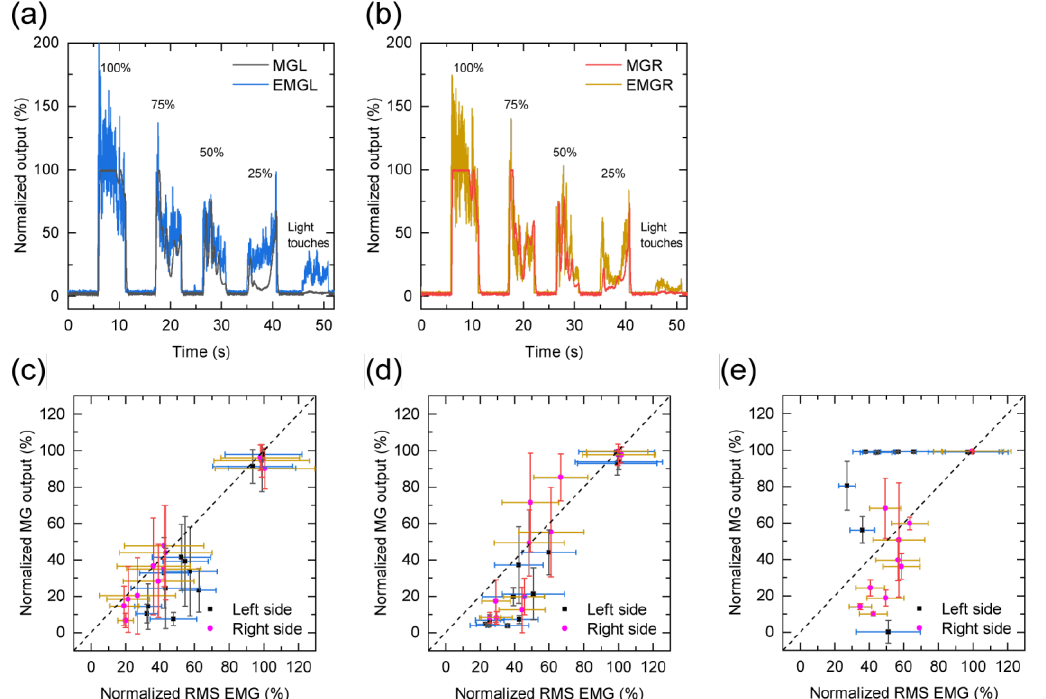
Figure 3. MG sensor outputs and the electromyograms (EMGs) during the teeth-clenching task at four different levels from 100% to 25% in steps of 25% and during light teeth touches. ( a ) Left-side sensors (MGL and EMGL); ( b ) right-side sensors (MGR and EMGR); and correlation between the MG sensor output and EMG (right and left sides, respectively) for each participant: ( c ) participant A, ( d ) participant B, and ( e ) participant C. Error bars represent the standard deviation.